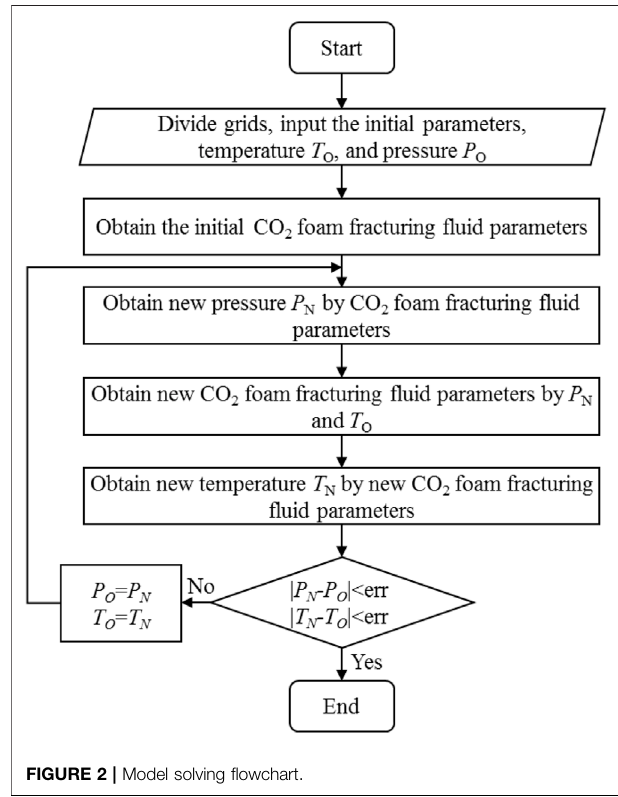
FIGURE 2 | Model solving fl